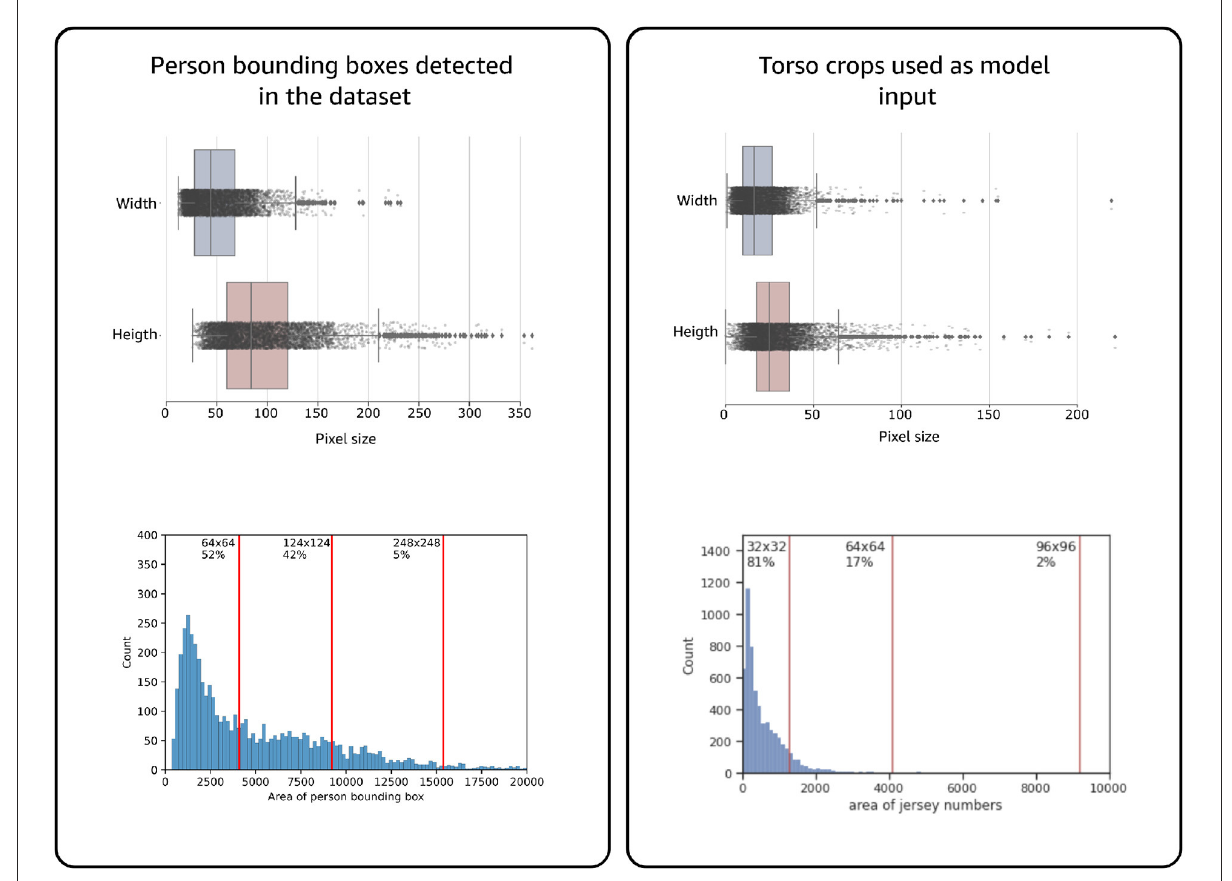
FIGURE4 Distribution of the sizes from person and torso bounding boxes. Note how the great majority of torso sizes is less than 32 × 32 pixel.